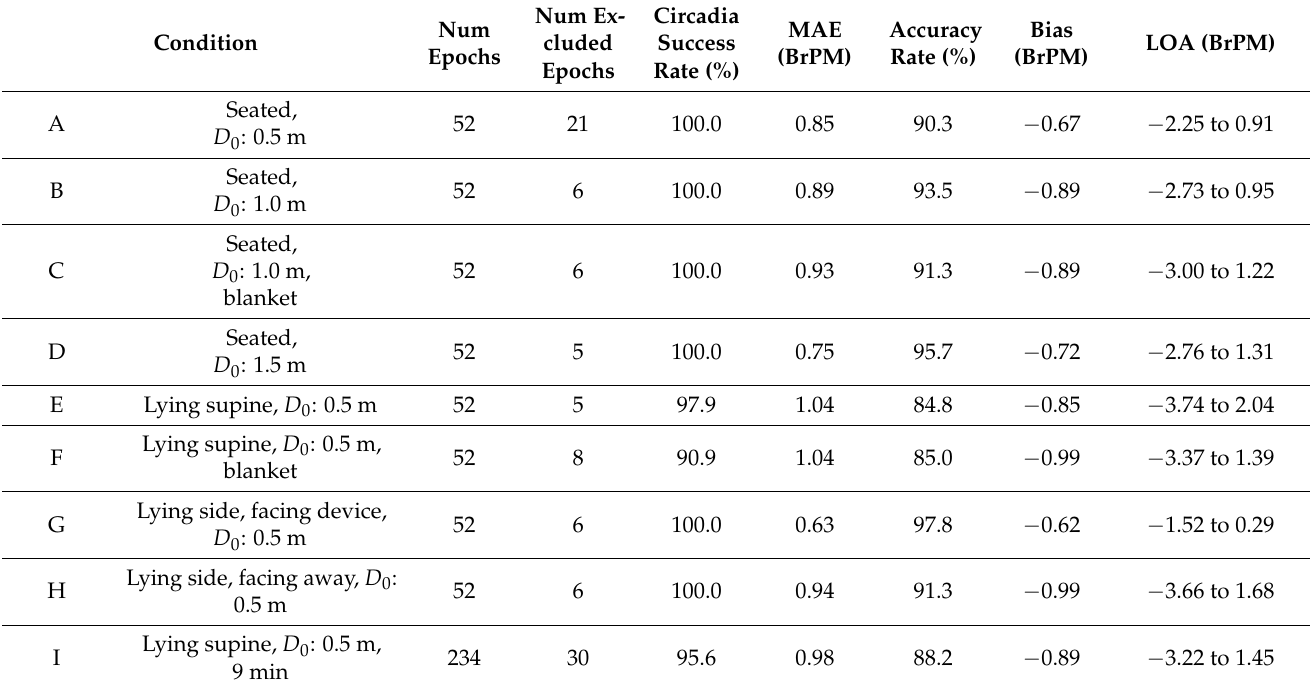
Table 3. Respiratory rate accuracy results for individual conditions in Study